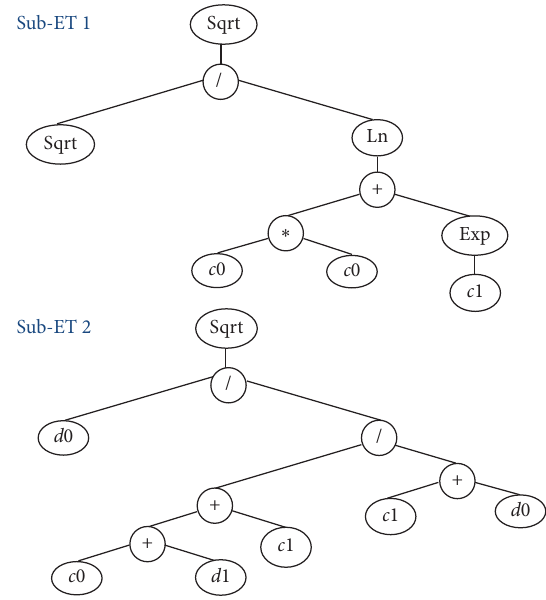
Figure 6: Expression tree of optimal GEP for the void ratio (Model